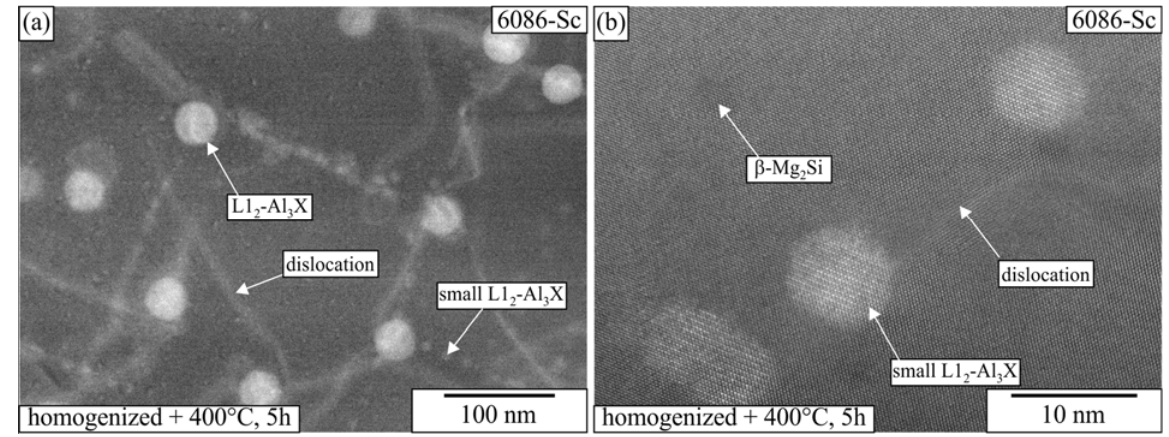
Figure 15. HAADF micrograph of L1 2 -Al 3 X dispersoids in 6086-Sc after homogenization and isothermal treatment at 400 °C for 5 h. ( a ) A lower magni fi cation with large and small dispersoids, ( b ) A higher magni fi cation with some smaller dispersoids.